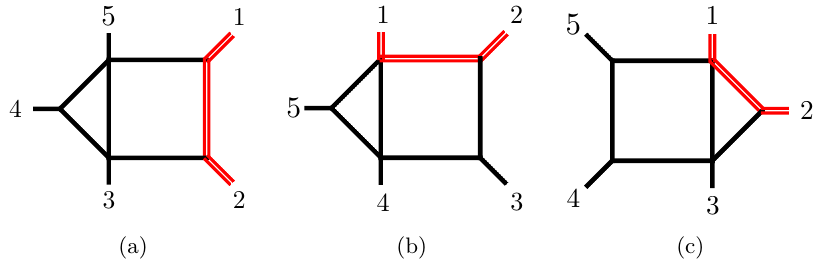
Figure 7 . The three genuine five-point box-triangle topologies covering the master integrals I 18 and I (a), I and I (b), and I – I (c), 19 20 21 22 26